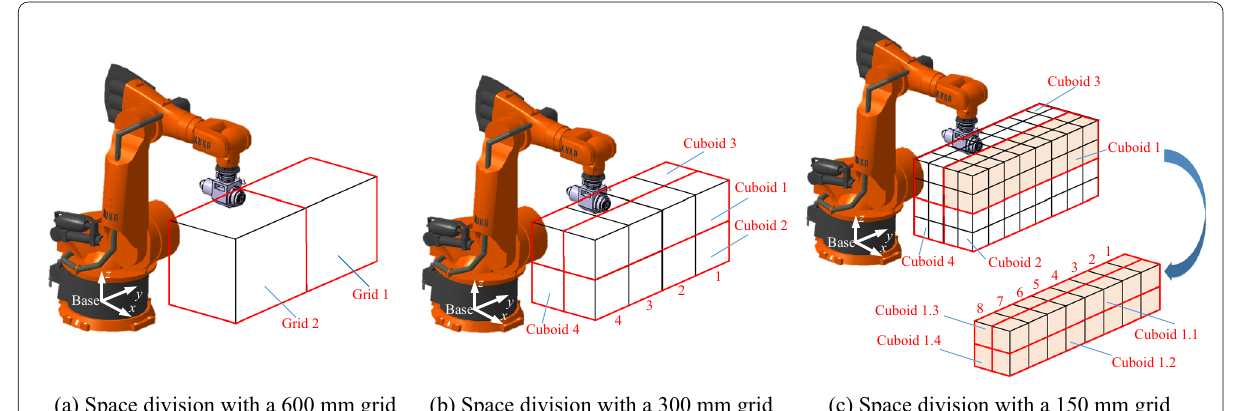
Figure 10 Space gridding with different grid sizes